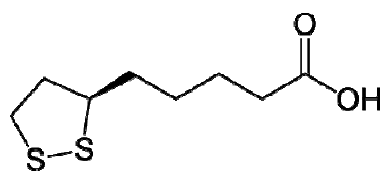
Figure 1. Chemical structure of ( R )- α -lipoic